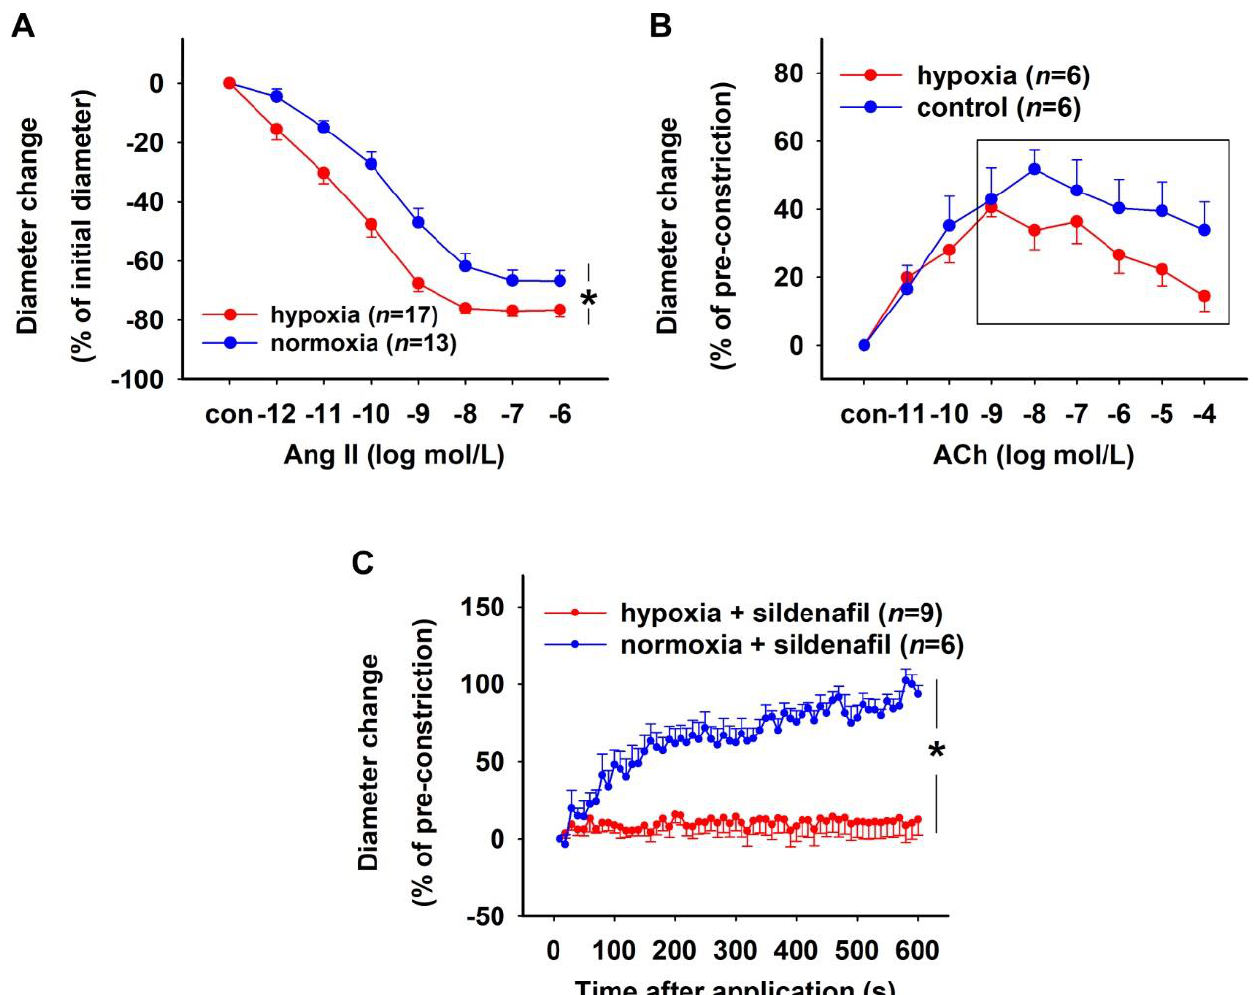
Figure 5. Effect of hypoxia/re-oxygenation on rat DVR. Vessels were pre-incubated either in a 0.1% oxygen (O 2 ) atmosphere (hypoxia) or in a 20.9% O 2 atmosphere (normoxia) for 30 min. ( A ) Concen- tration – response curves showing constriction induced by 10 −12 – 10 −6 mol/L Ang II in hypoxic and normoxic vessels. Hypoxia/re-oxygenation group of vessels showed a significantly stronger con- striction in response to Ang II compared to the normoxia group (Brunner test, * p < 0.001). ( B ) Con- centration – response curve showing relaxation induced by 10 −11 – 10 −4 mol/L ACh in hypoxic and normoxic vessels pre-constricted with 10 −6 mol/L Ang II. Hypoxic vessels relaxed significantly less in response to higher concentrations of ACh (10 −9 – 10 −4 mol/L, highlighted in a box) compared to normoxic vessels (Brunner test, * p < 0.05). ( C ) Time – response curves showing the effect of PDE inhibition using 10 −6 mol/L sildenafil on hypoxic and normoxic vessels pre-constricted with 10 −6 mol/L Ang II. Sildenafil caused normoxic vessels to relax, while no relaxation was observed in hy- poxic vessels for the entire duration of the experiment (Brunner test, * p < 0.001).